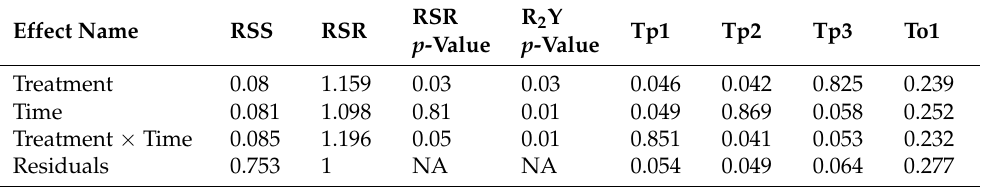
Table 2. AMOPLS output from the comparison between SO-based parenteral lipid emulsion (SOPLE) and FO-based parenteral lipid emulsion (FOPLE) before and after the intervention using treatment, time, and interaction as main effects using the lipidomics